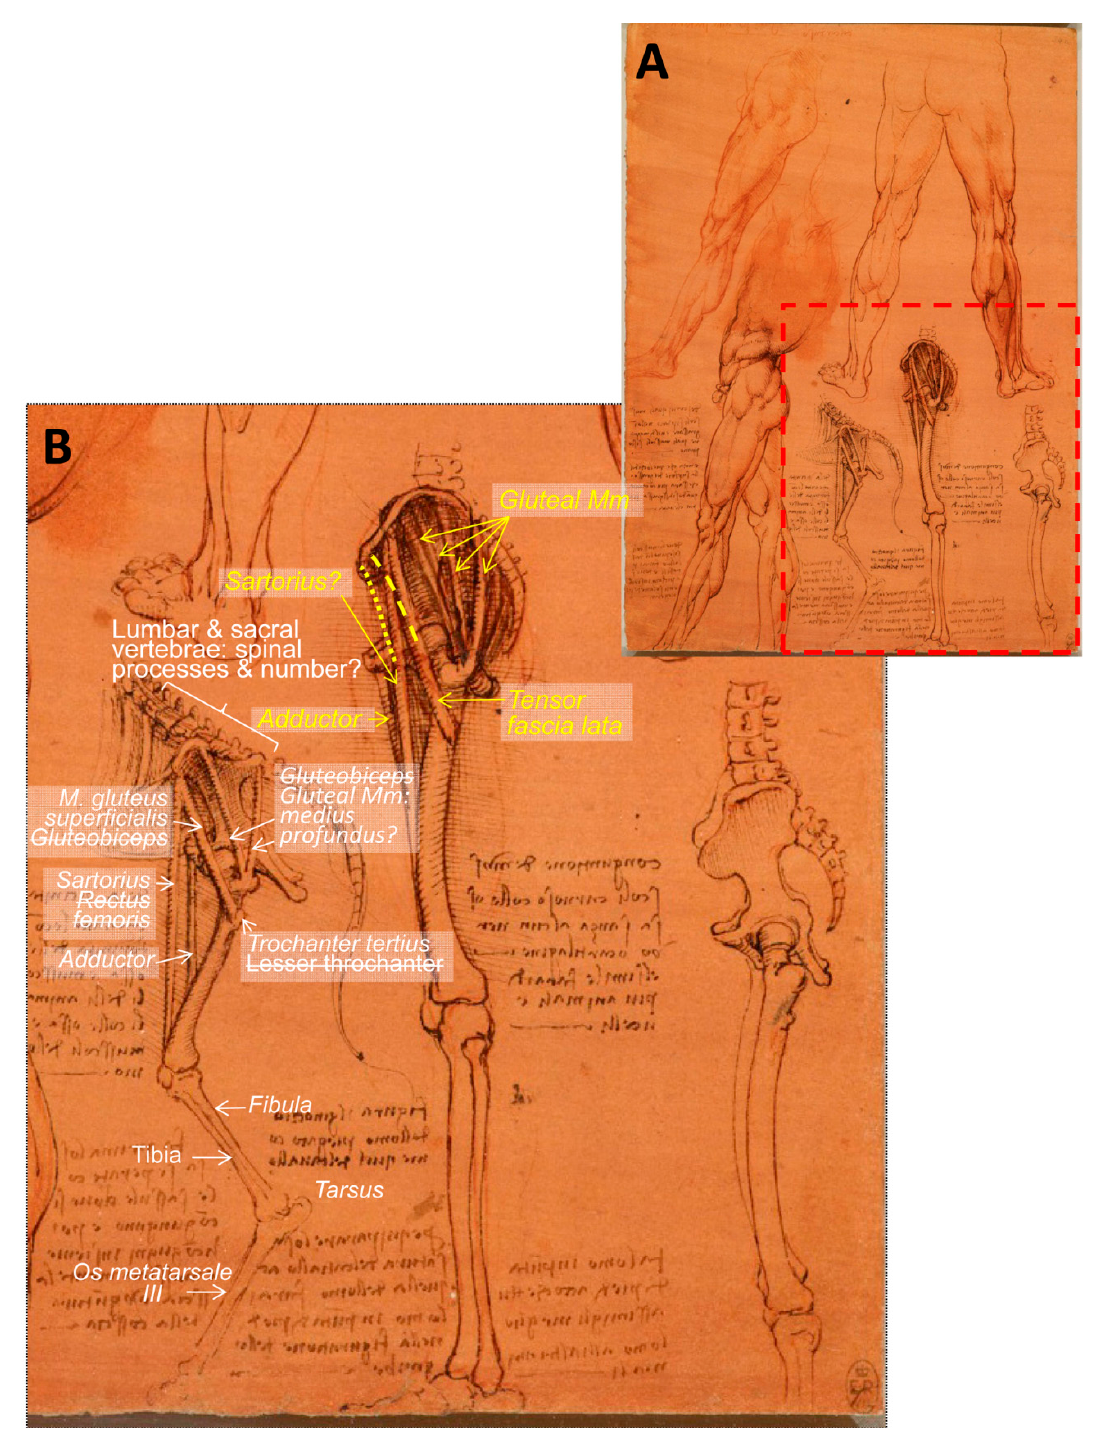
Figure 7. Series of comparative anatomy of man’s leg and horse’s pelvic limb—Number 1. ( A ) Whole drawing. ( B ) Inset at higher magnification showing a horse left pelvic limb (on the left) and a human left leg (centre and right), lateral aspect. The leg muscles and bones of man and horse c.1506–1508. Modified from www.rct.uk/collection/912625 (Royal Collection Trust [3]). This image is credited as